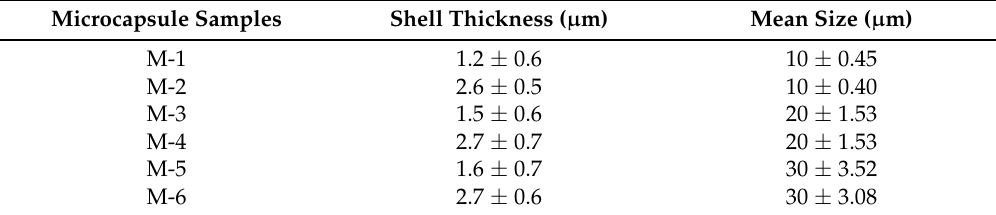
Table 1. Microcapsule samples with various shell thickness and mean size.